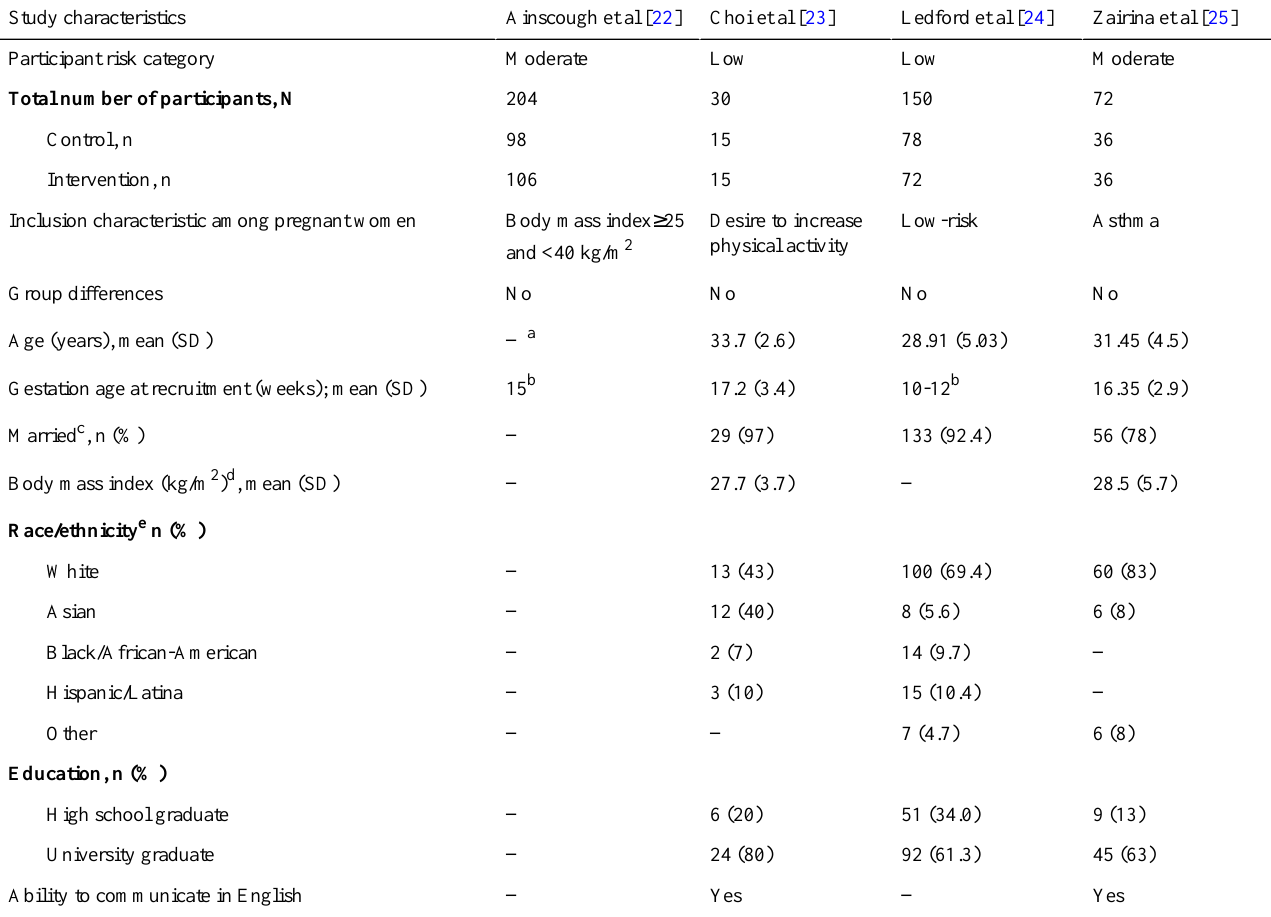
Table 3. Participant